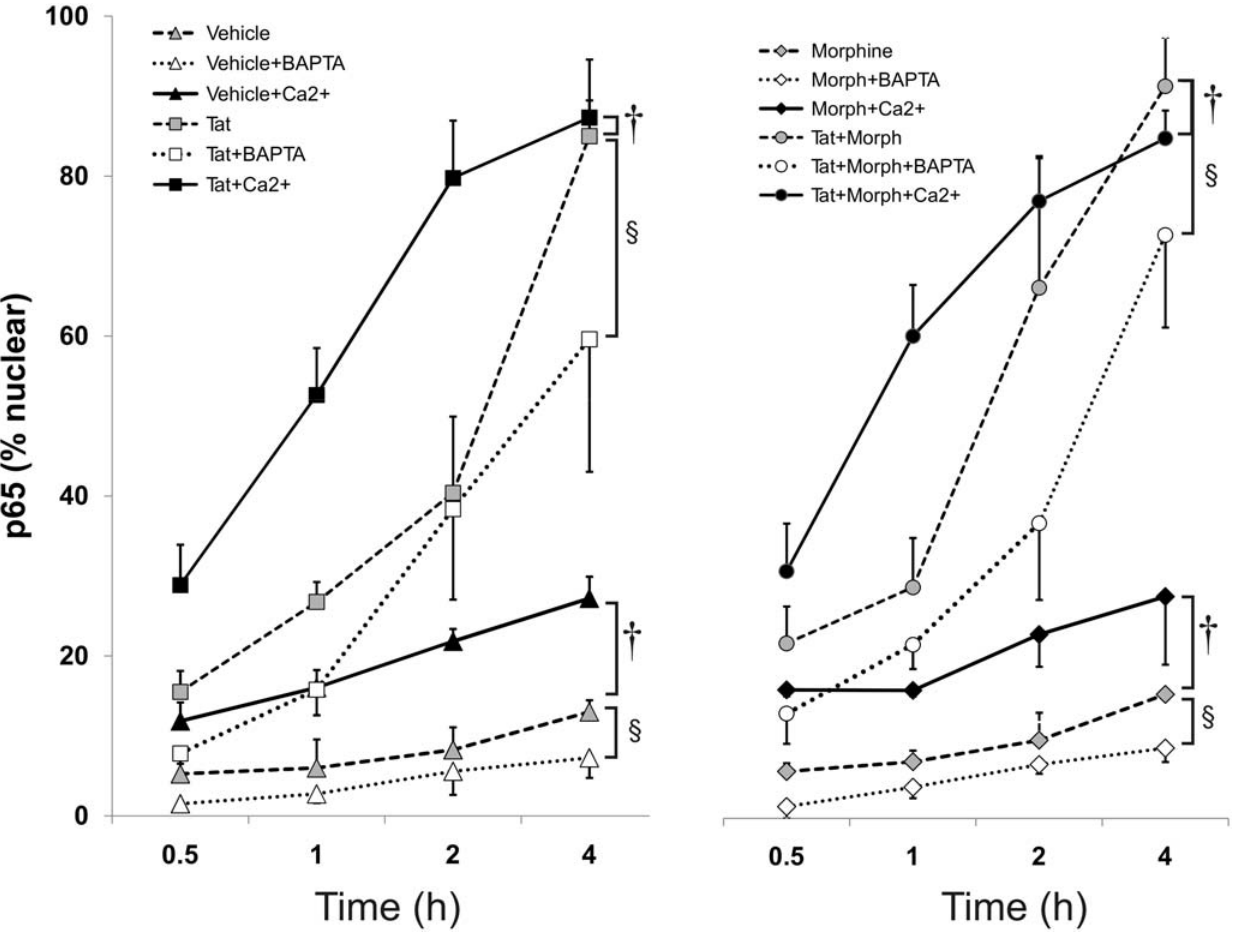
Figure 6. Ca 2 + modulates morphine and/or HIV-1 Tat-induced trafficking of the p65 (RelA) subunit of NF- k B into the nucleus of astrocytes. Chelating [Ca 2 + ] i with 10 m M BAPTA significantly delays Tat and/or morphine-(Morph or MOR) induced nuclear import of p65(RelA), while artificially elevating [Ca 2 + ] i by excessive (5 mM) Ca 2 + outside the cell ([Ca 2 + ] o ), accelerates p65 subunit trafficking into the nucleus. Note that p65 nuclear shuttling occurs both in vehicle and in BAPTA-treated astrocytes, suggesting that nucleocytoplasmic shuttling occurs continuously. It also infers that other events such as the phosphorylation of specific NF- k B subunits are operative ( 1 P , 0.05, vehicle vs. BAPTA -treated cells; { P , 0.05, control vs. 5 mM [Ca 2 + ] o -treated cells).